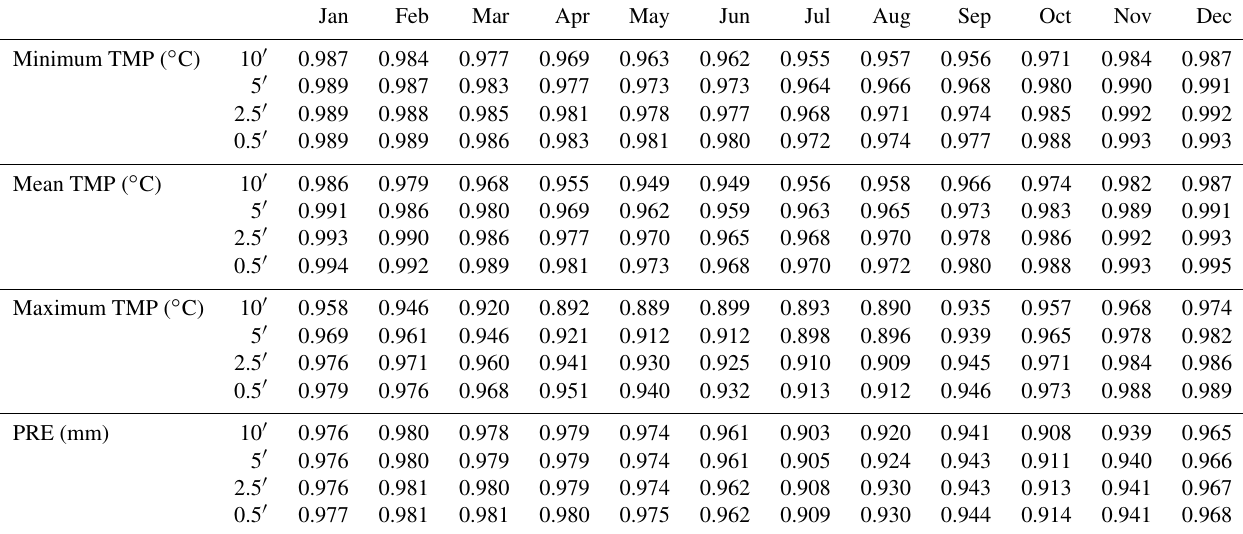
Table 2. Correlation coefficients between the observed and WorldClim climatology datasets at different spatial resolutions over independent weather stations for 1970–2000.